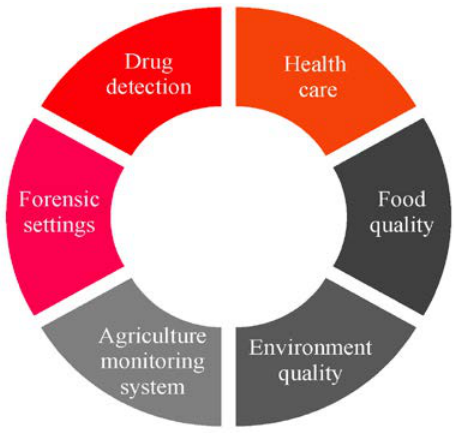
Figure 1. Wide application of sensors for ionic analytes.